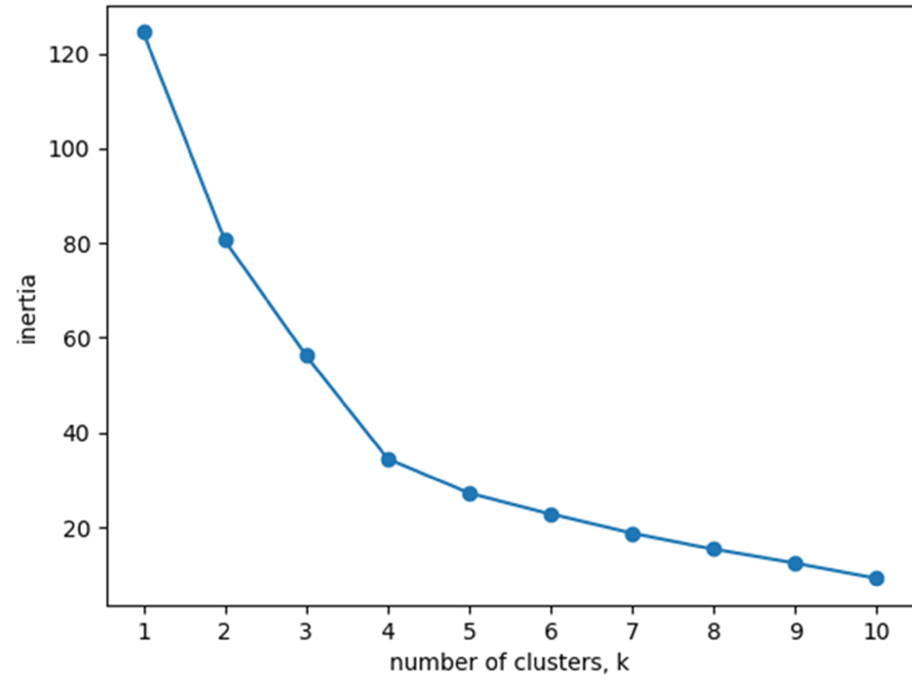
Figure 2. Graph of inertia values according to the number of clusters.